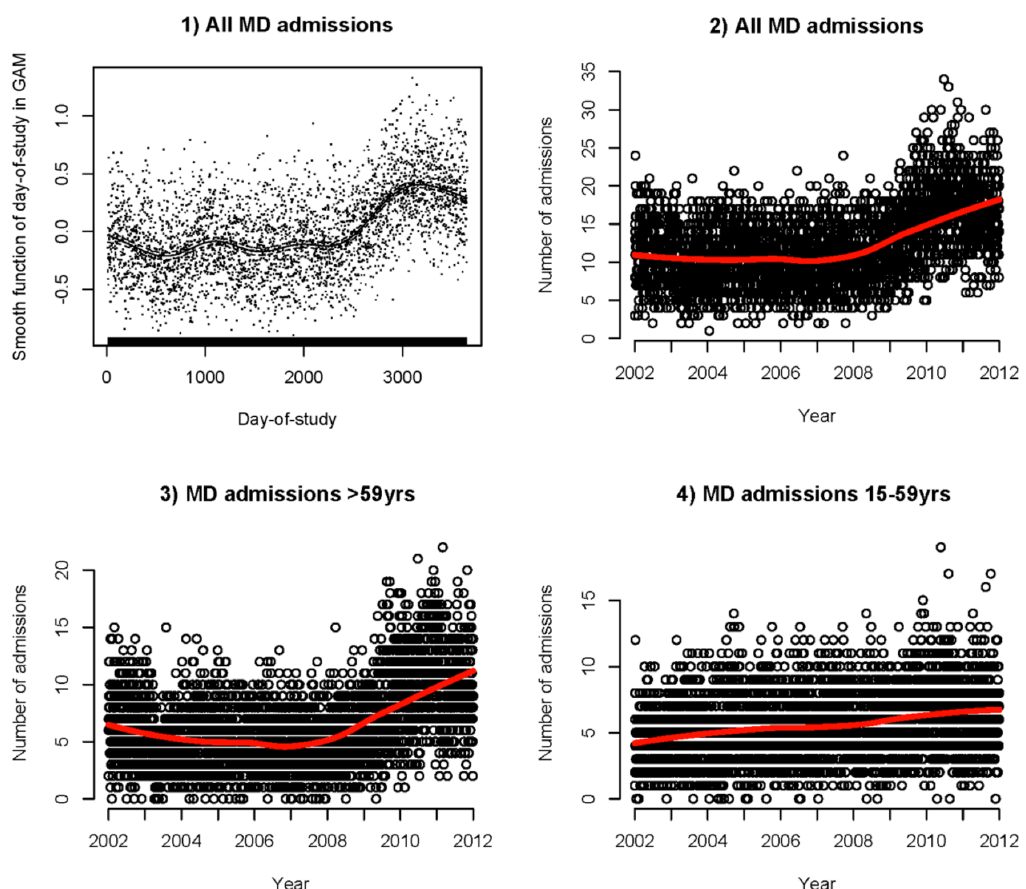
Figure 1. Long-term trend plot of mental-disorders admissions ( 1 ) after adjusting for temperature, relative humidity, NO 2 level, seasonal trend, day-of-week, holiday effect, and same day rainfall, ( 2 ) long-term trend without adjustment for overall admissions, ( 3 ) long-term trend without adjustment for age >59 years and ( 4 ) long-term trend without adjustment for age below 60 years in Hong Kong,